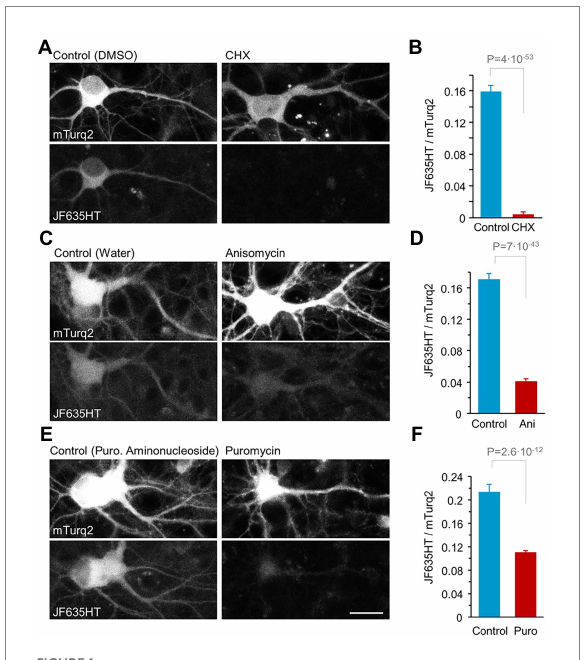
FIGURE 1 Quantitative assessment of protein synthesis